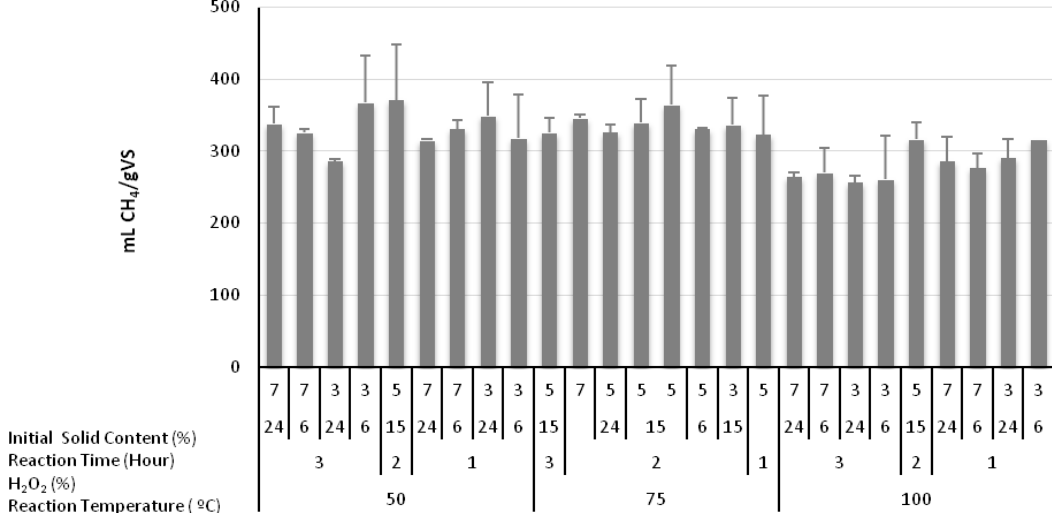
Figure 2. Methane generation due to the impact of alkaline H 2 O 2 pretreatment.